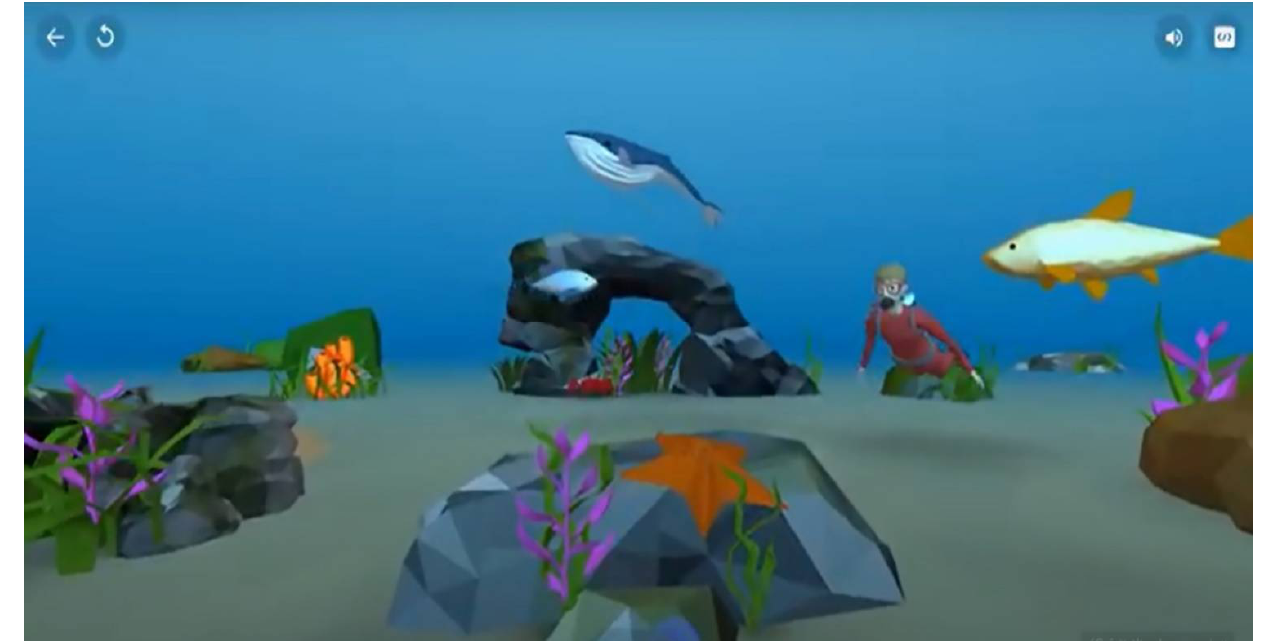
Figure 1. Example # 1 of students ’ virtual environments (outer space) .